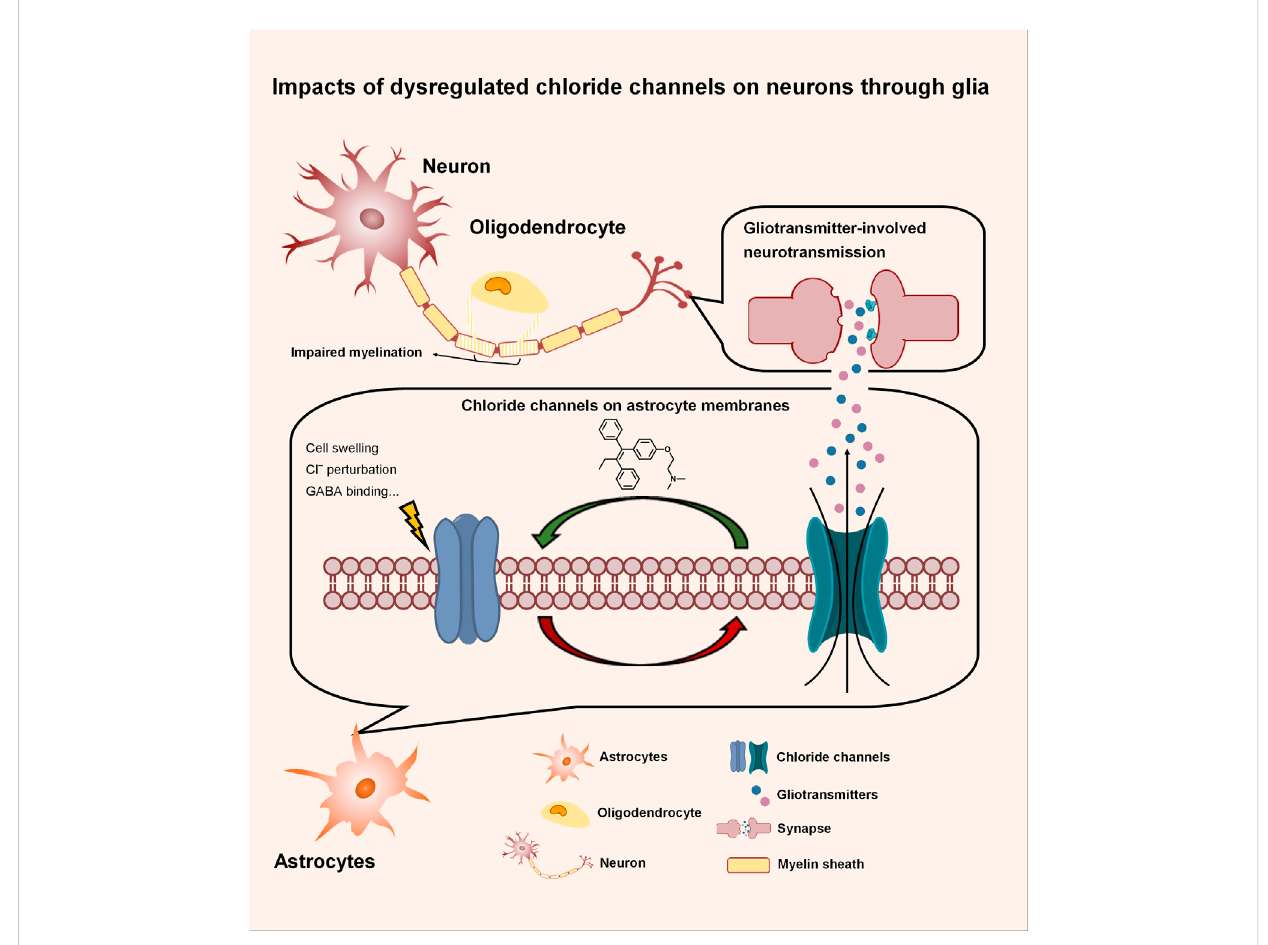
FIGURE 1 Impacts of dysregulated chloride channels on neurons through glia. Chloride channels in the CNS not only directly modulate neuronal excitability, but also indirectly impact neuronal functions through the gliotransmitters released from astrocytes via gating organic anions such as glutamate and GABA. In neurological disorders, dysregulated chloride channels release excessive neurotransmitters, causing neuronal